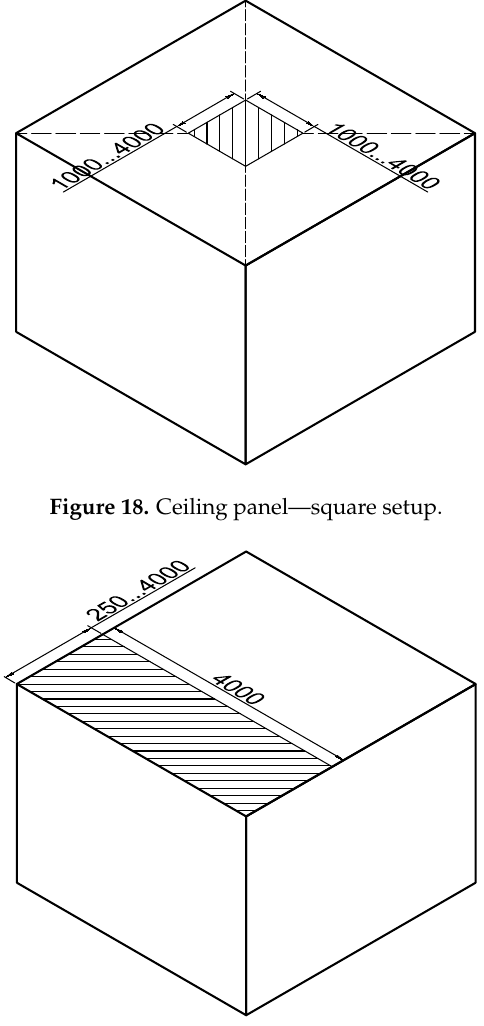
Figure 19. Ceiling panel—strip